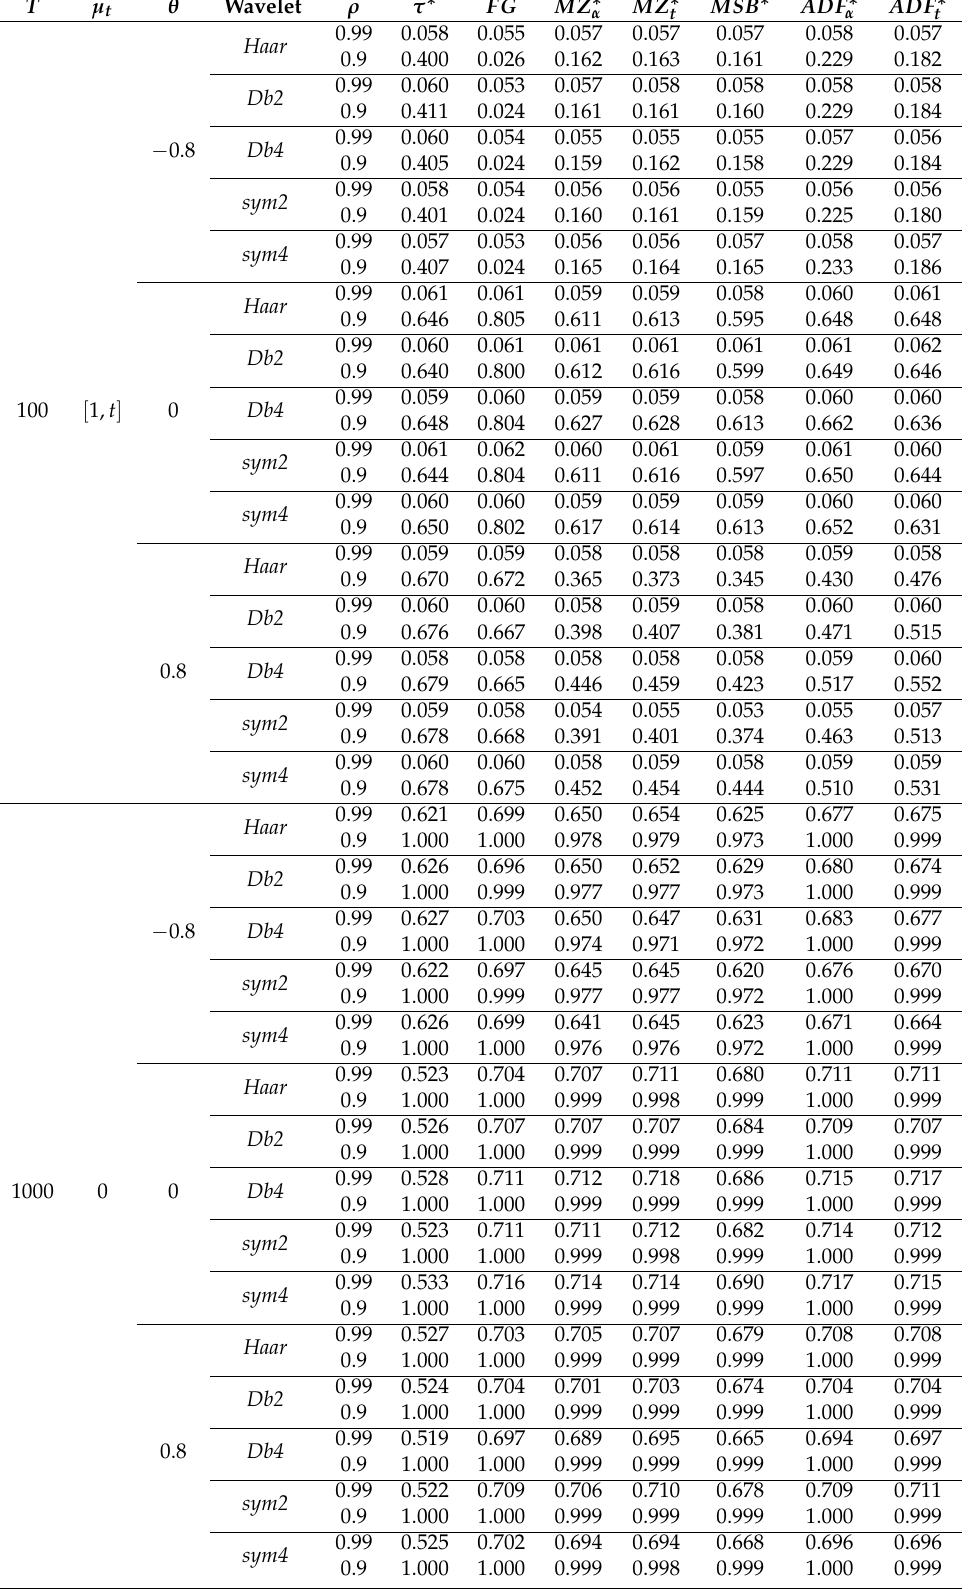
Table 7. The size-adjusted power of wavelet based unit root tests,